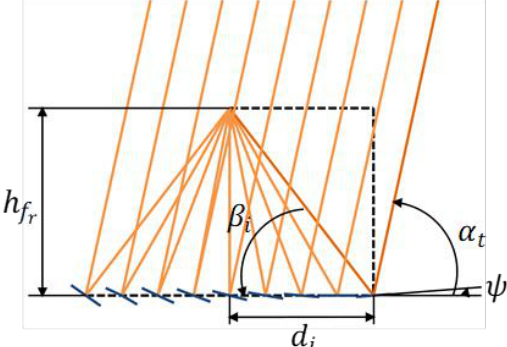
Figure 6. Angle of inclination of the i -th mirror and its determinants.